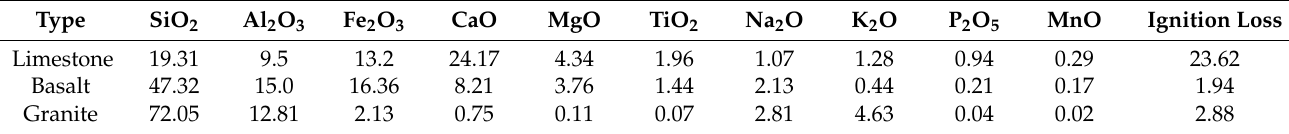
Table 3. Chemical components of the